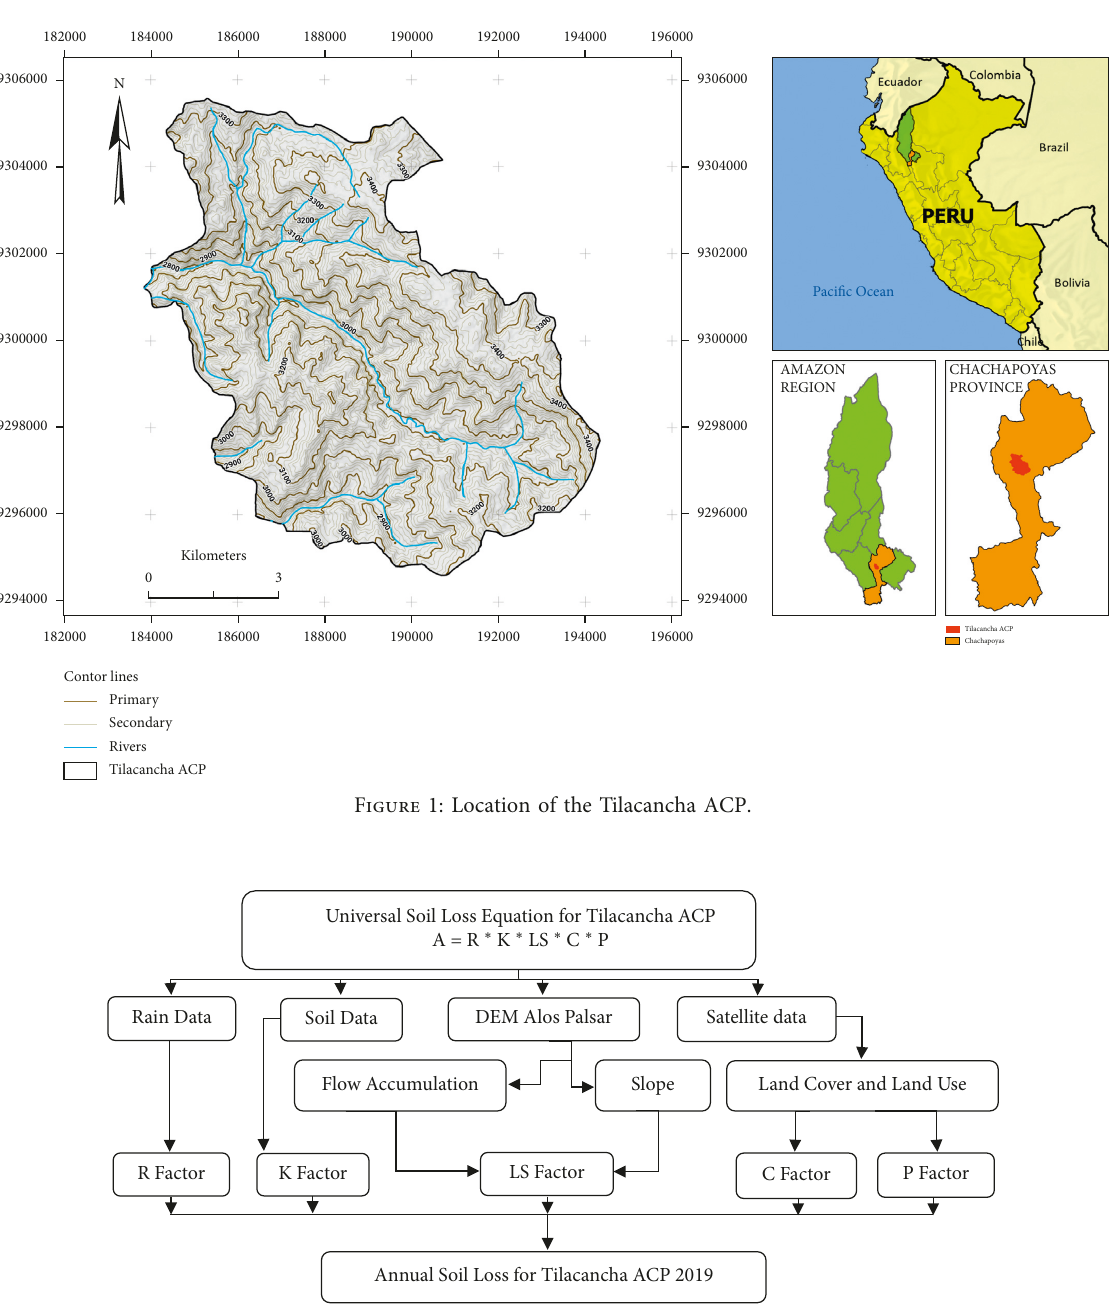
Figure 2: Methodological flow to integrate the Universal Soil Loss Equation (USLE), adapted from the work of Rizeei et al. [13], where A is annual soil loss in the Tilacancha ACP for 2019, R factor: rain data, K factor: soil data, LS factor: flow and slope accumulation, C factor: land cover and land use, and P factor: conservation practices.